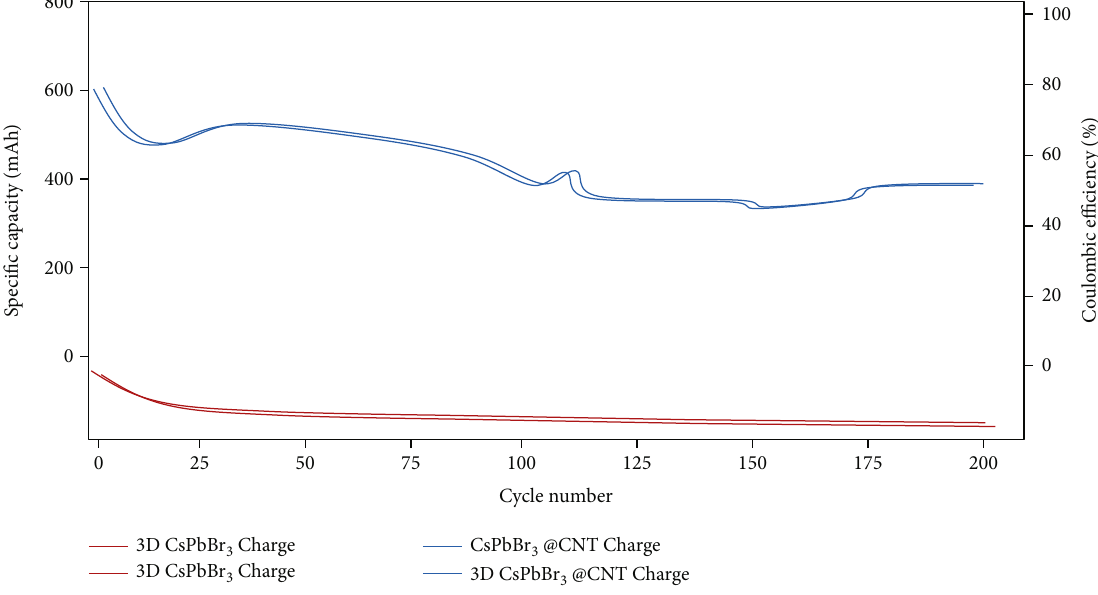
Figure 6: Galvanostatic charge-discharge (Coulombic e ffi ciency) performance of monomeric CsPbBr3 and CsPbBr3@CNT